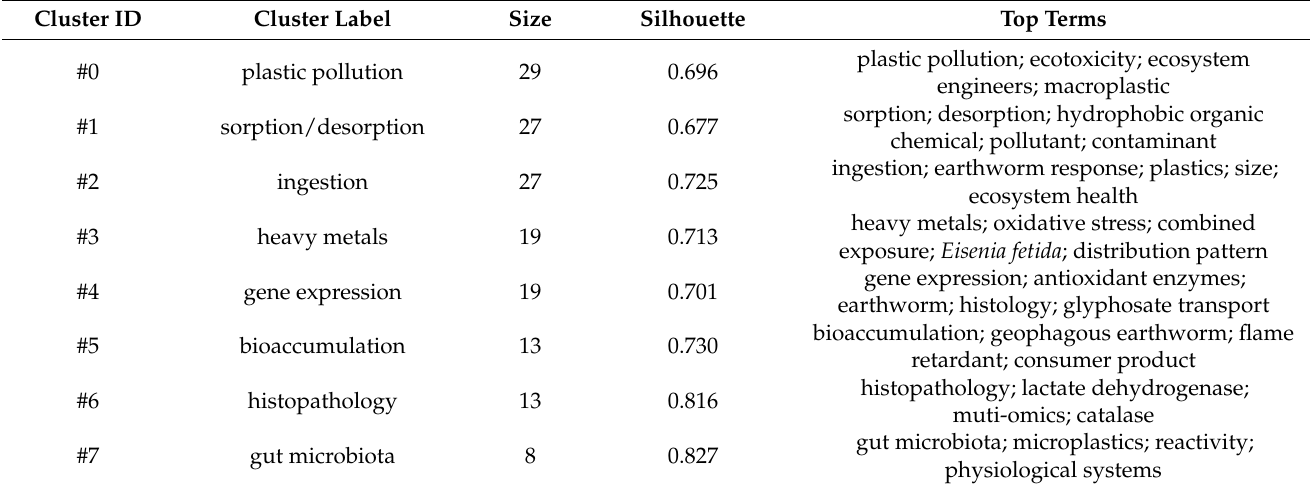
Table 3. Knowledge clusters in the field of micro(nano)plastic toxicity to earthworms based on keyword